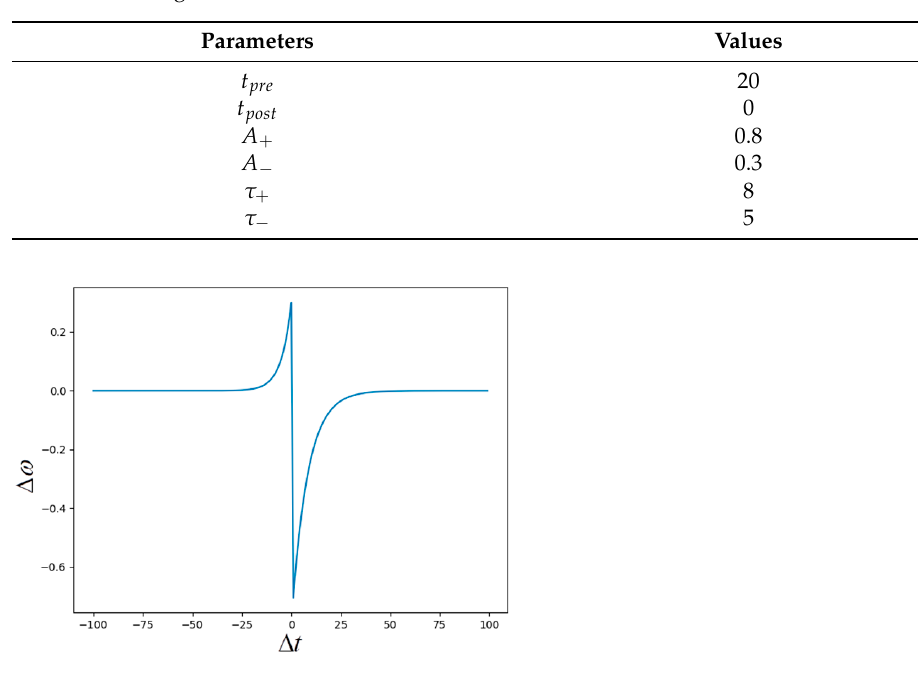
Figure 5. Curve of STDP Algorithm.